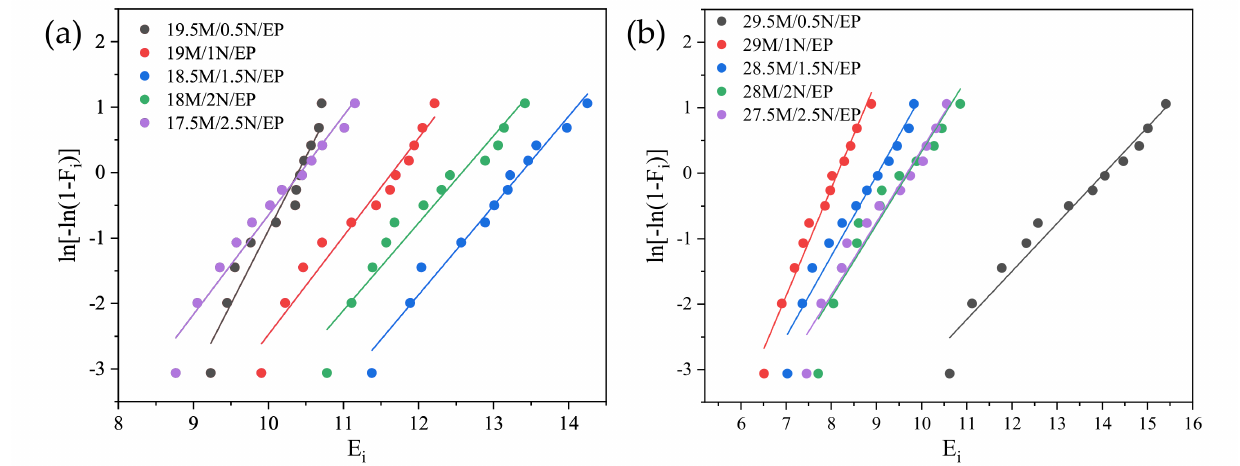
Figure 16. Weibull distribution of micro-nano composite SiC/EP breakdown strength. ( a ) 20 wt% SiC/EP; ( b ) 30 wt% SiC/EP.